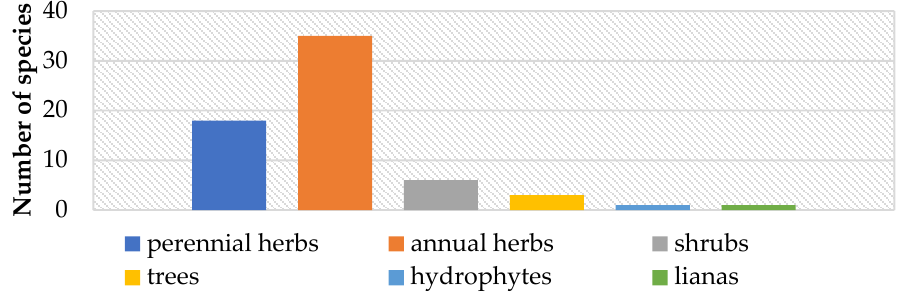
Figure 2. Life forms of IAS.